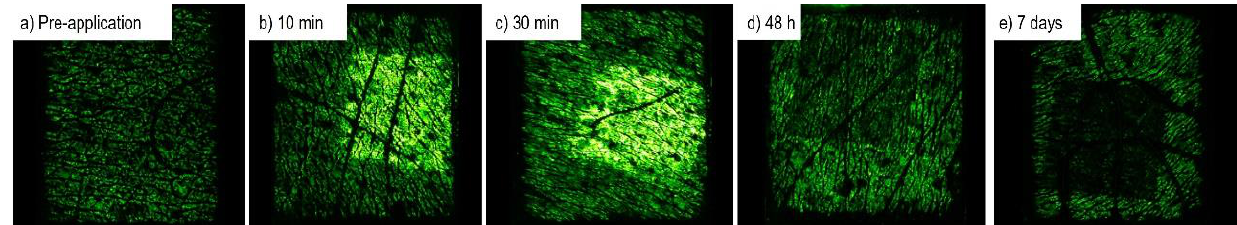
Figure 4. Typical dielectric permittivity images of one individual from each time point (( a ) pre-application, ( b ) 10 min after application of HD-MAP, ( c ) after 30 min, ( d ) 48 h, and ( e ) 7 days). Note that an initial increased response is observed within 30 min after application, followed by a decreased response compared to pre-application after 48 h and 7 days.